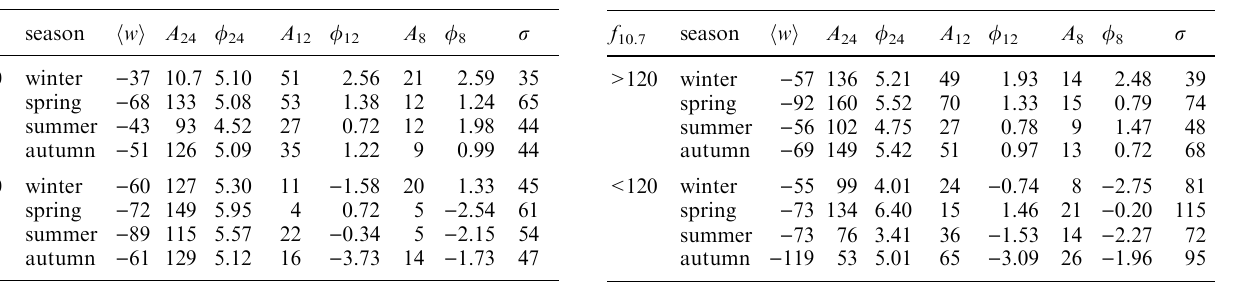
Table 13. Harmonic decomposition at 354 km